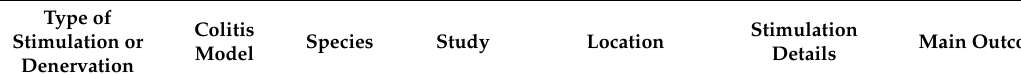
Table 1. Overview of studies that investigated cutting the nerves or nerve stimulation in models of